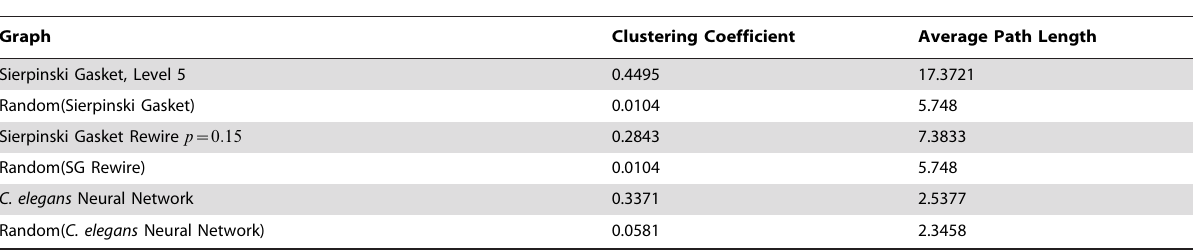
Table 1. Clustering coefficient and path length.